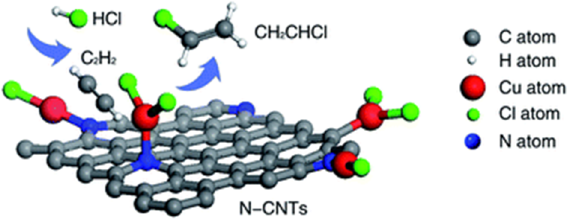
Figure 16. Cu-N-CNT catalyst for acetylene hydrochlorination [112]. N-CNT: N-doped carbon Cu-N-CNT catalyst for acetylene hydrochlorination [112]. N-CNT: N-doped nanotubes. carbon